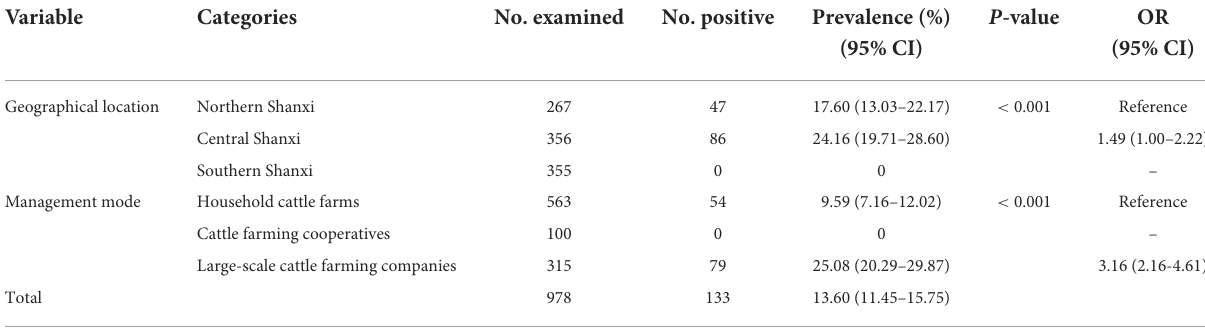
TABLE 2 Analysis of the related variables of N. caninum infection in cattle in Shanxi Province. Variable